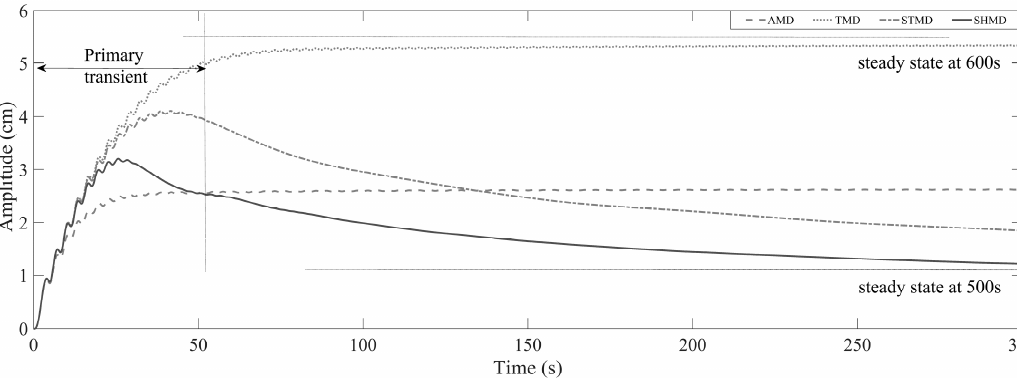
Figure 9. Transient and steady ‐ state Crms response of the different control device configuration under harmonic loading at tuning frequency (excitation frequency 1 rad/s).